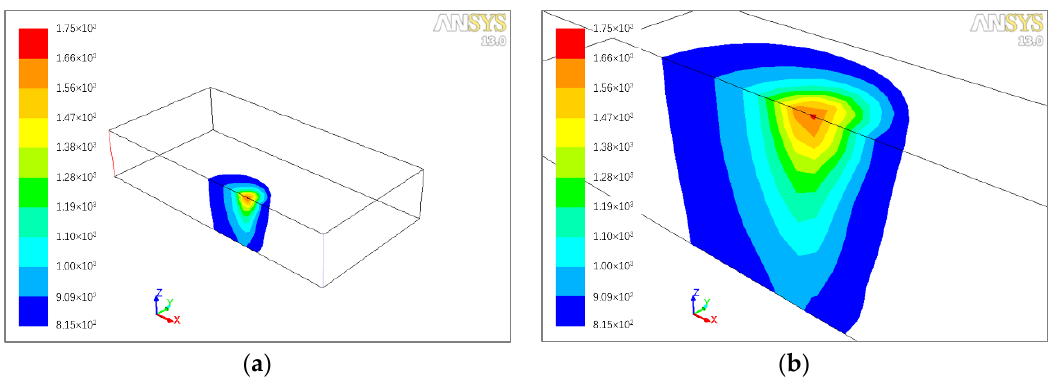
Figure 5. Shape and dimensions of the weld pool for flat welding (at finish point): ( a ) whole model; and ( b ) magnified melt pool region.